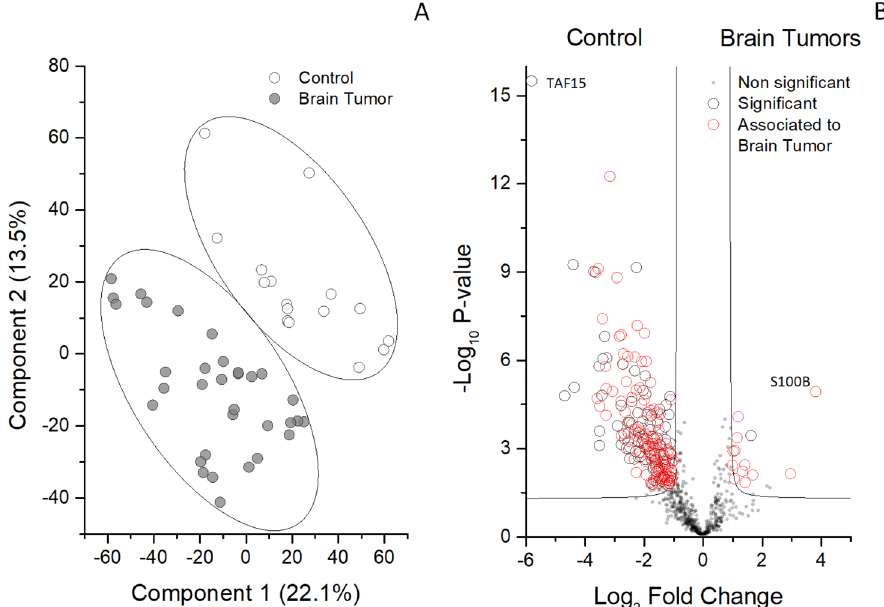
Figure 2. Multidimensional scaling (MDS) and volcano plot of CSF proteome from EVD of control and brain tumor samples. ( A ) Scatter plot of MDS analysis of control (white circles) and brain tumor samples (grey circles). Ellipsis indicate 95% confidence interval. Plot shows clustering of two distinct groups (tumor and control samples). ( B ) Volcano plot of all the identified proteins in all samples. Grey, open black and red circles indicate the non-significant, significant or previously described as associated to brain tumor protein changes between the two groups, respectively. Black line indicates the limits of statistical significance. Grey circles above the black line indicate the proteins with an identity <